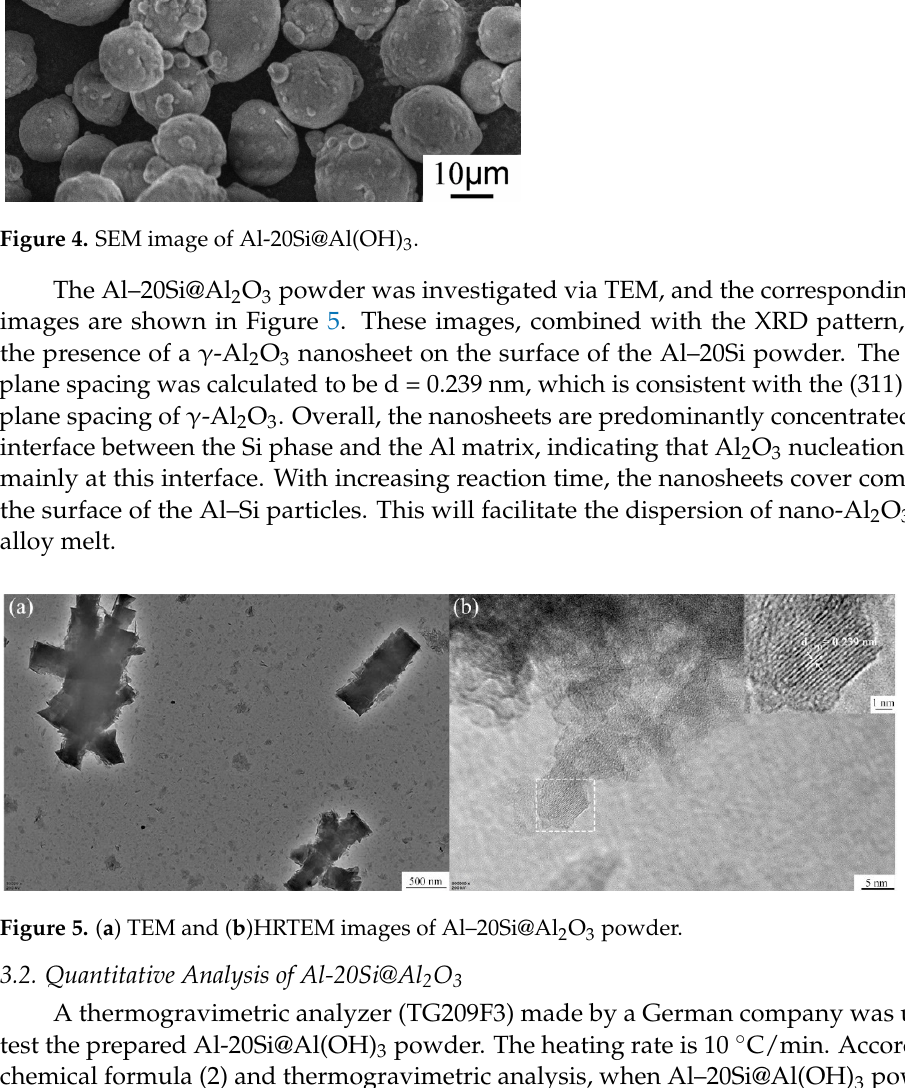
Figure 3. XRD pa tt ern of Al–20Si@Al 2 O 3 powder.